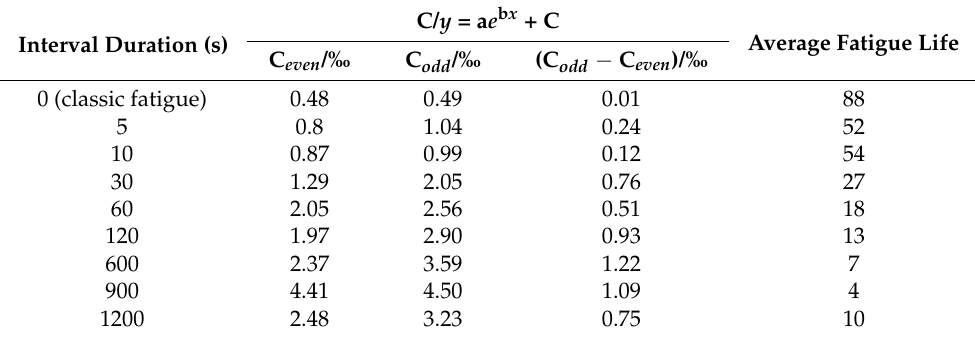
Table 1. C values of the exponential fit of the residual strain and fatigue life of samples subjected to different fatigue interval